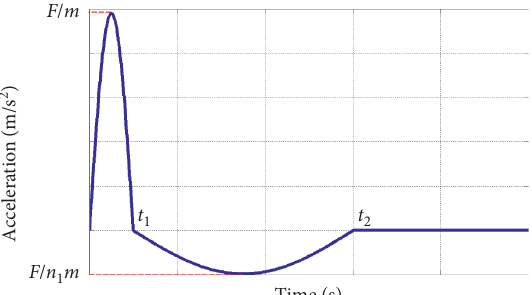
Figure 4: The influence of the preload amplitude 􏽥 A and the fitting parameter μ on the 􏽥 F (b) Different values of the parameter μ .